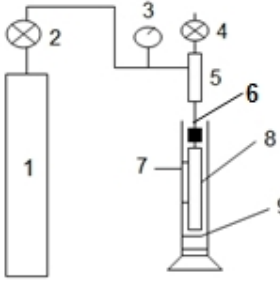
Figure 2. The apparatus for determining the maximum pore size of the hollow